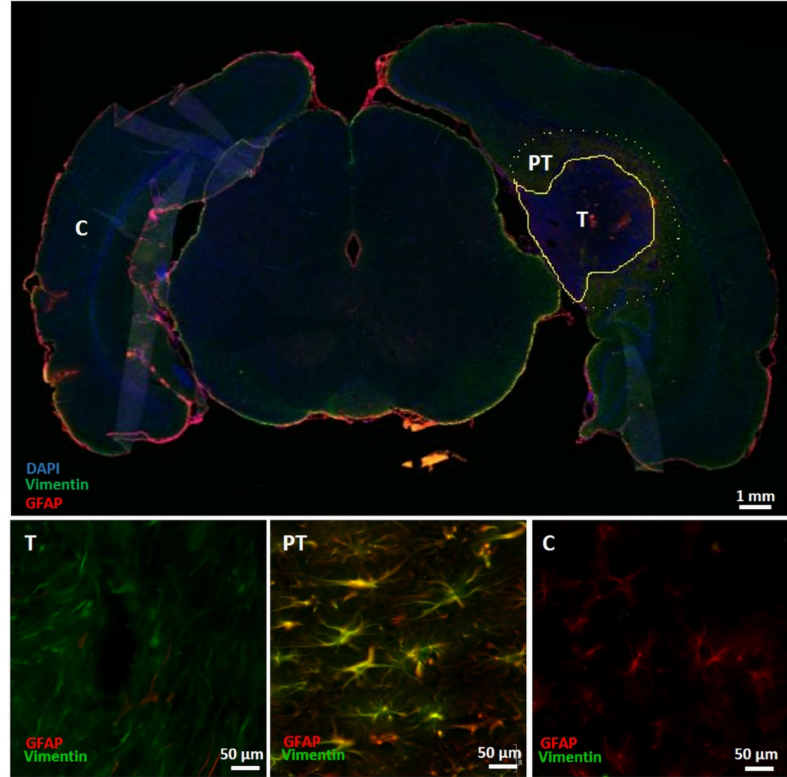
Figure 4. Immunohistochemical analysis for GFAP and vimentin. The upper panel shows an overview slice with GFAP, vimentin and DAPI expression. The tumor mass (T) contains more densely packed cells compared to neighboring non-tumor tissue, as demonstrated by DAPI-positive nuclei. This zone is delineated by a yellow line. Around the tumor mass, a rim of GFAP/vimentin double-positive cells can be observed, and this peritumoral area (PT) was delineated by a yellow dashed line. The lower panel shows ROIs in the different zones. T: ROI in the tumor mass with GFAP and